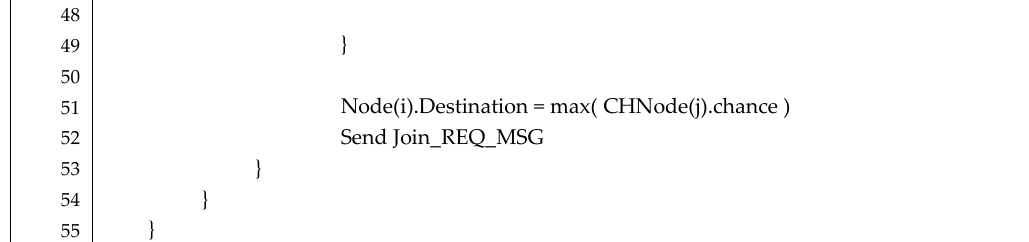
Figure 11. Pseudocode of CH and cluster configuration.